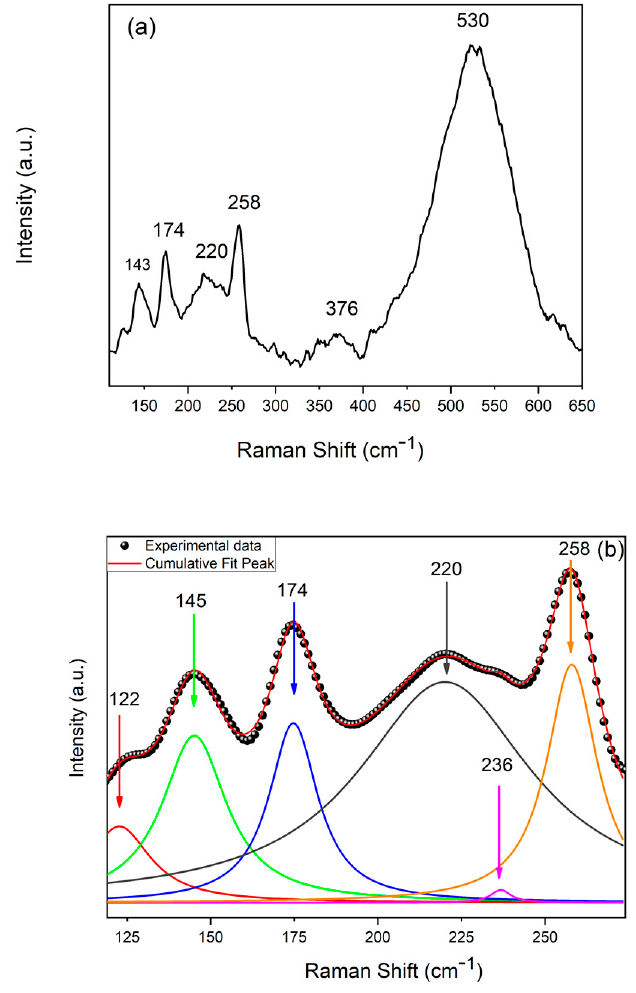
Figure 12. Raman spectra of samples: ( a ) original spectrum and ( b ) deconvolution. NWs were obtained at pH = 2.7 with a gallium content of 57 mM and at 1.53 mA/cm 2 .